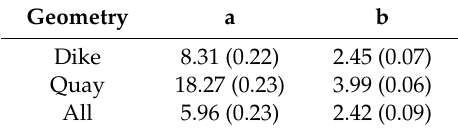
Table 2. Coe ffi cients a and b in Equation (13) for di ff erent geometries (after Van Doorslaer et al.